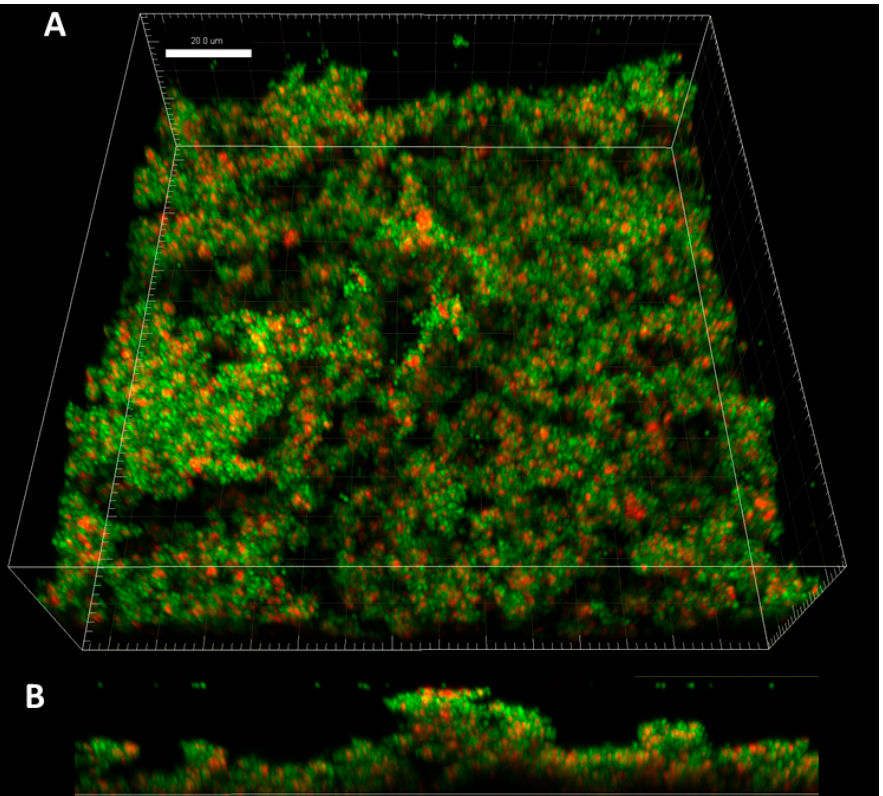
Figure 2. The Z axis image stack visualizing ATCC 6538 staphylococcal biofilm from the side aerial perspective ( A ). Part ( B ) of the figure shows the vertical cross-section through the three-dimensional biofilm structure, where the regions of various height and density are explicitly visible. Microscope Cell Observer, magnification 40 × . The cellular density of biofilms, along the Z-axis, was higher in their middle (M) parts than in the top (T) and the bottom (B) parts (Figure 3). In turn, the cellular density of the T and B parts were comparable. Such observation was recorded for 100% ( n = 10) biofilms formed by analyzed strains (Table S2).